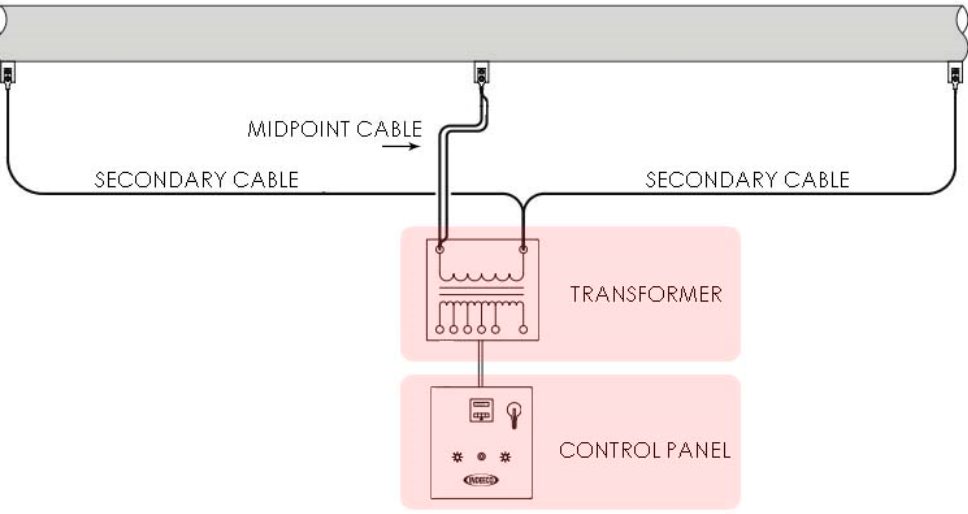
Figure 6. End-point electrical connection (Adapted from [27]).